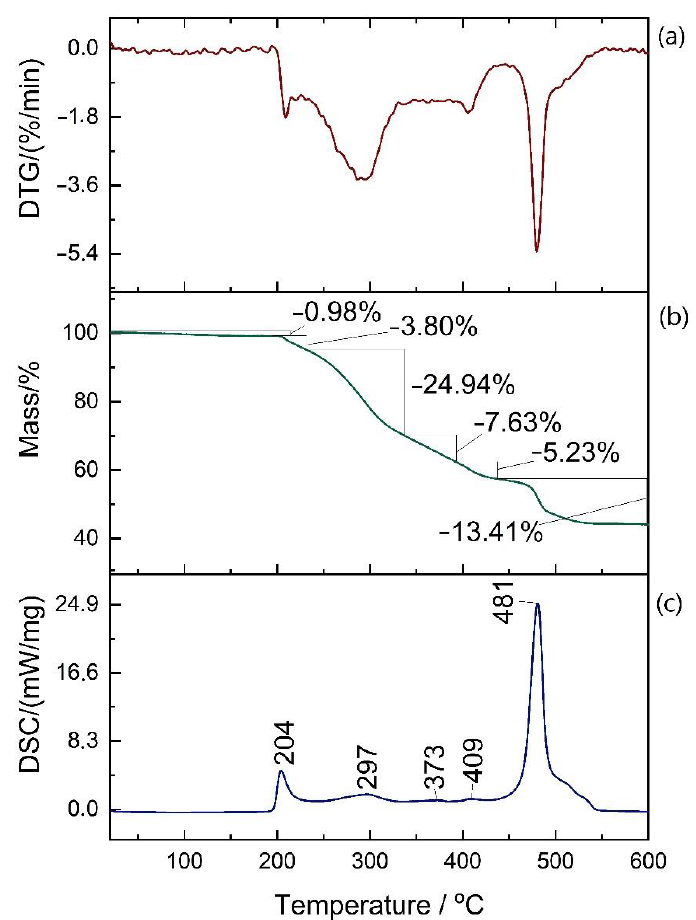
Figure 7. Result of DTG ( a ), TGA ( b ), and DSC ( c ) for sample 1 of the reference (I), investigated after tensile test.